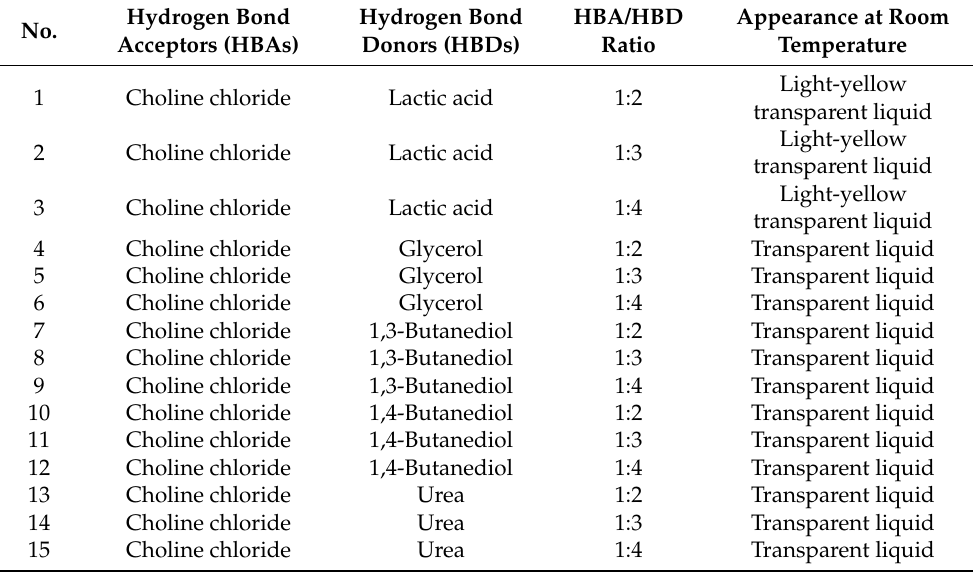
Table 5. List of DESs synthesized in this